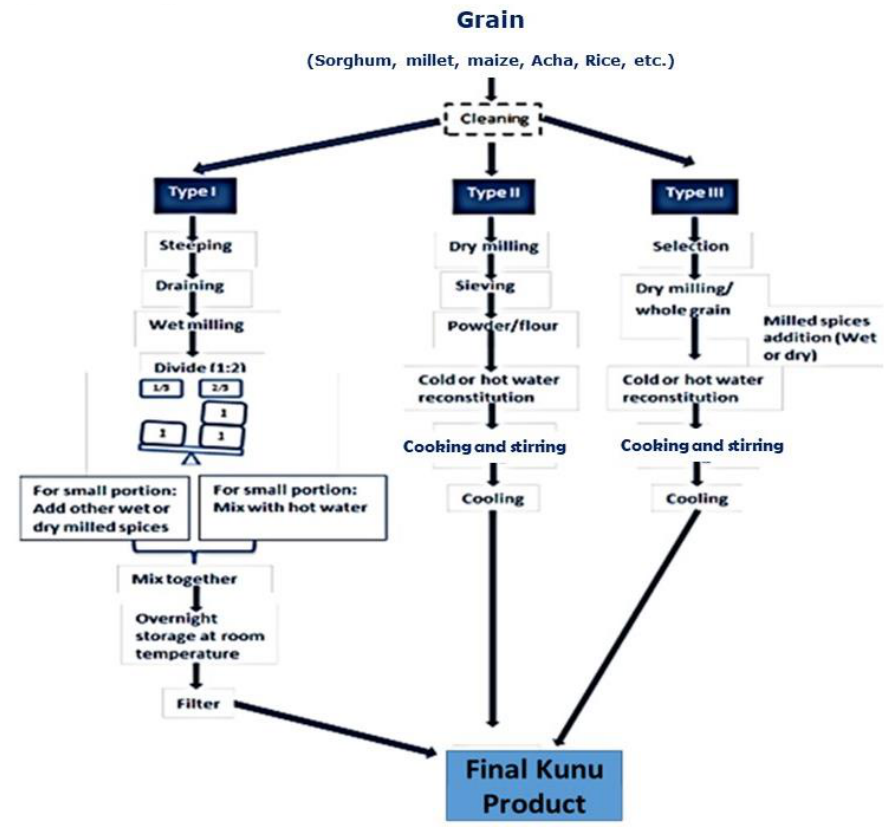
Figure 1. Flowchart of processes involved in the production of varieties of Kunu drinks.